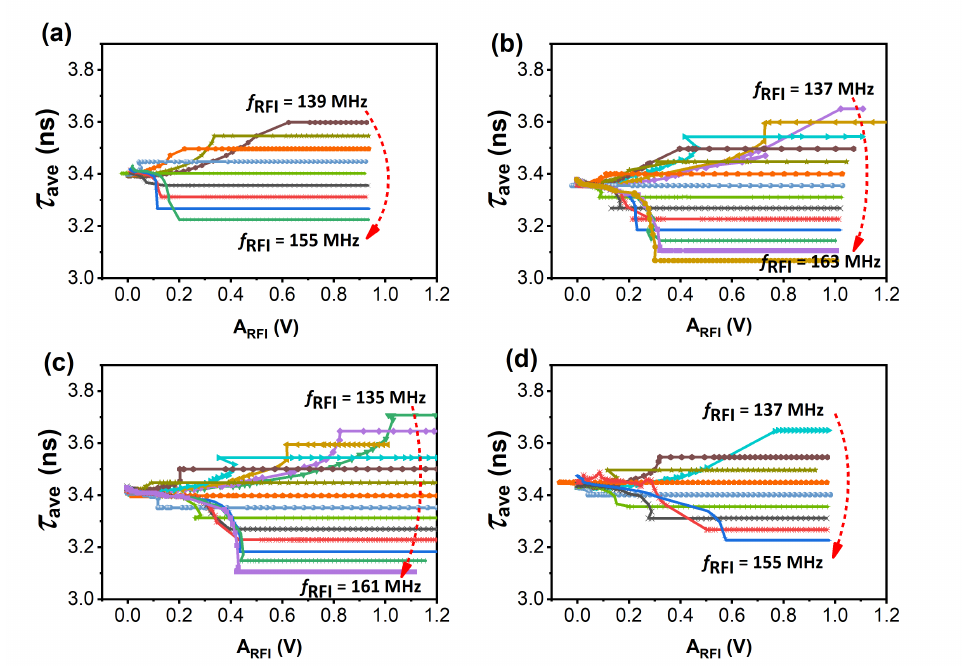
Figure 16. Locking cones of ROs with the same 120 pF capacitor loads: ( a ) 7-stage RO; ( b ) 9-stage RO; ( c ) 11-stage RO; ( d ) 13-stage RO. Three kinds of interference were selected for comparison: no interference, 0.9 V and 145 MHz, and 0.9 V and 150 MHz. The bitstream is shown in Figure 17. The latter two kinds of interference could easily lock all ROs. Binary images show that, when all ROs were locked, the output bitstream of the TRNG presented a certain regularity. A discrete Fourier transform (DFT) test in the NIST suite was carried out to detect the periodicity of the bitstream. The p -value was far less than 0.01, which represents the latter two conditions that destroy the randomness of the TRNG output.